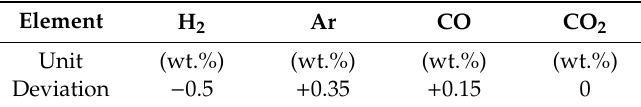
Table 7. Deviation factor of each